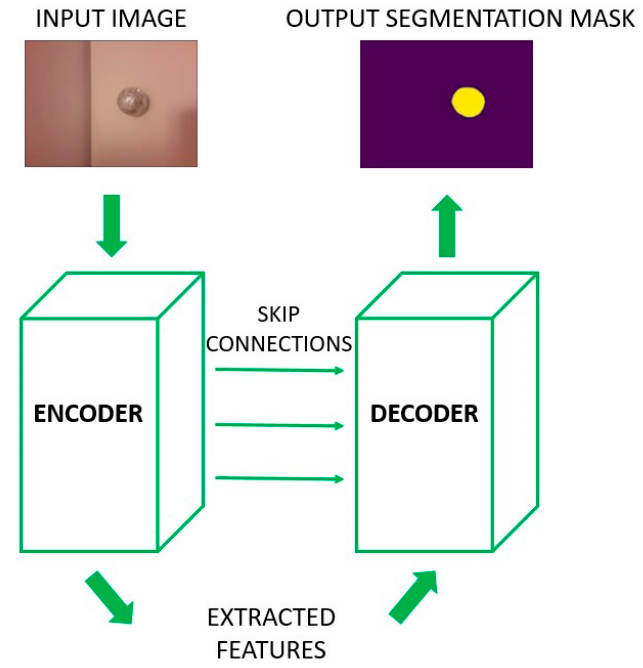
Figure 2. U-NET neural network architecture.